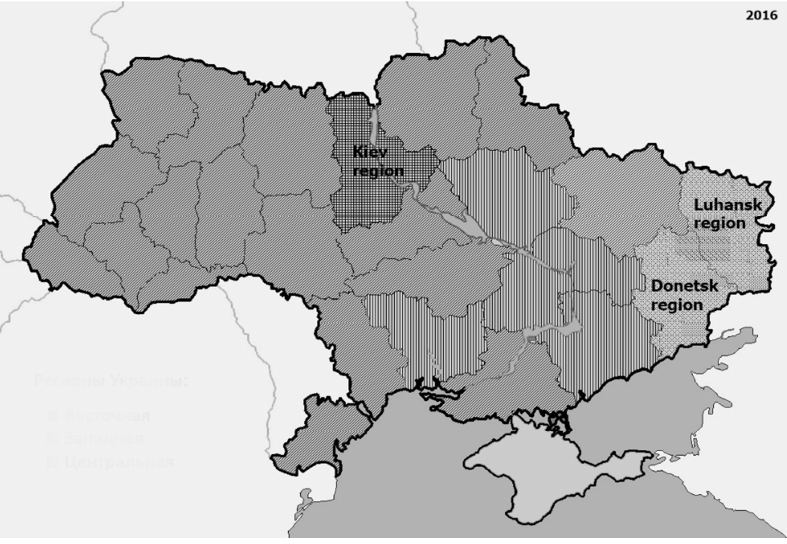
Figure 9. Mapping sustainable development of regions in Ukraine according to their affiliation to the attributive groups in